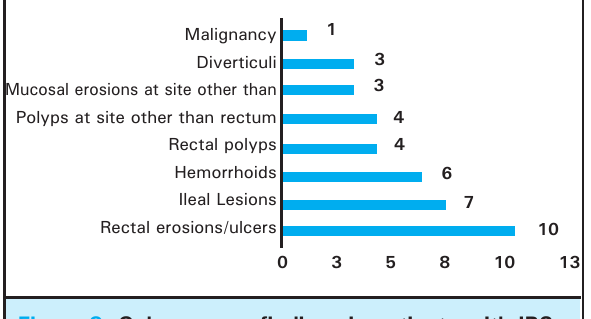
Figure 3. Colonoscopy findings in patients with IBS.